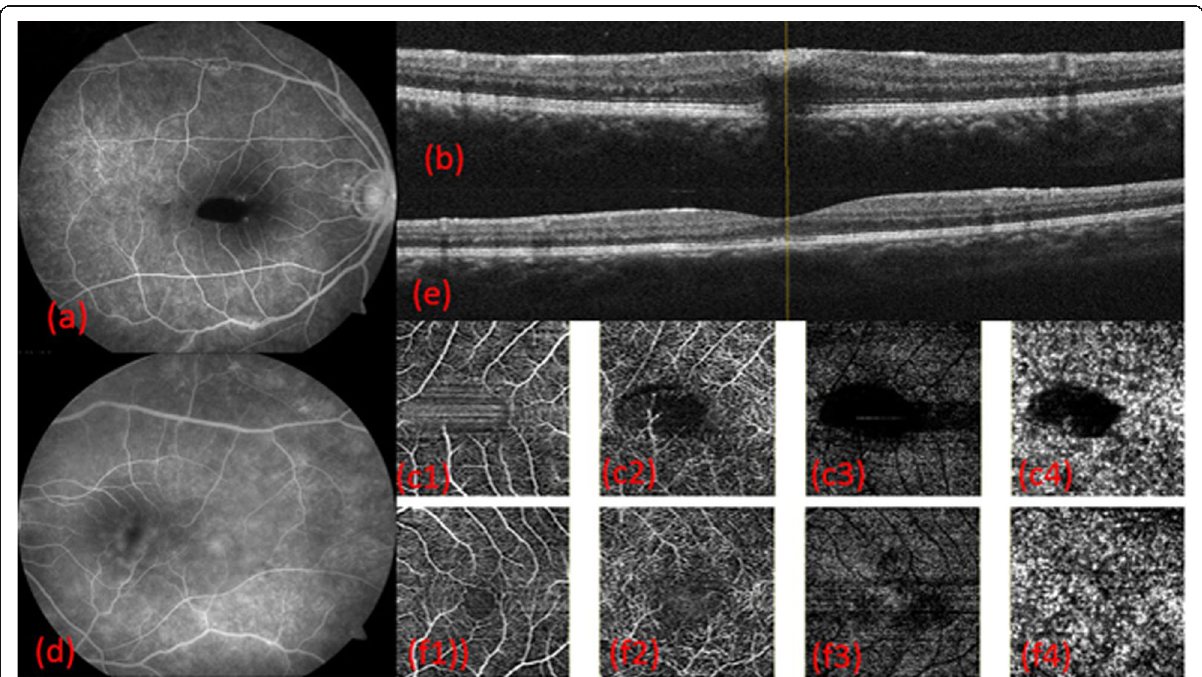
Fig. 3 17 years male vision right eye counting finger 1 m and left eye 6/24; (a) FA: Right eye with blocked fluorescence (b) OCT: shows sub-ILM bleed (c1 – 4) OCTA at SCP, DCP, outer retina and choroid shows back-shadowing due to bleed (d) FA: Left eye with leakage at macula (e) OCT shows outer retina mild irregularity (f1 – 4) OCTA at SCP,DCP, outer retina and choroid level suggestive of DCP enlargement